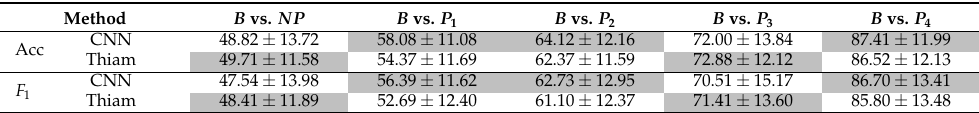
Table A2. 5 × LOSO average performance using the EDA (RespiBan) sensor of the PMDB for the Thiam and CNN architectures. Performance metrics are given as average accuracy (upper) and F 1 score (lower half) ± standard deviation. Moreover, the best performing approach is highlighted in grey.